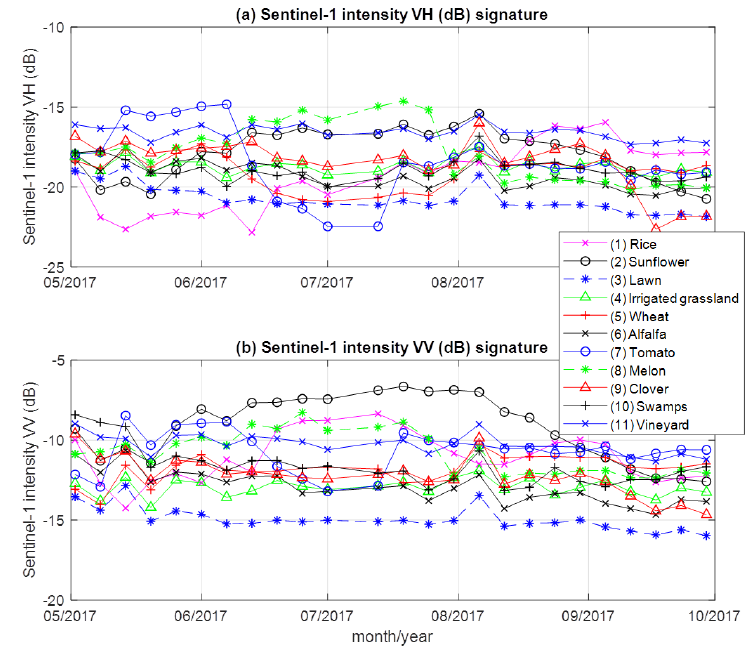
Figure 2. The temporal profiles of the eleven different classes which respect to the VH ( a ) and VV ( b )